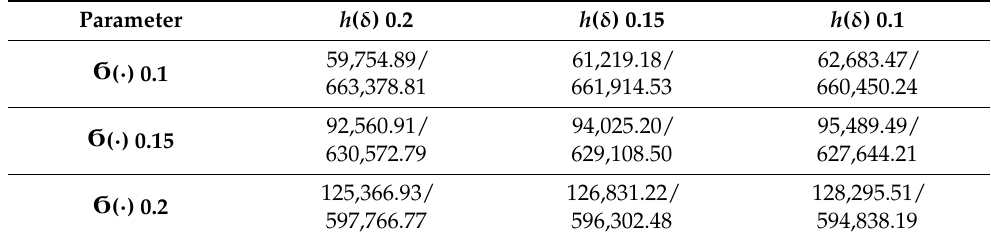
Table 8. Correlation of the Subordinate’s and the Principal’s objective functional using P.B.I.M. with the same parameters of the reward and penalty system.